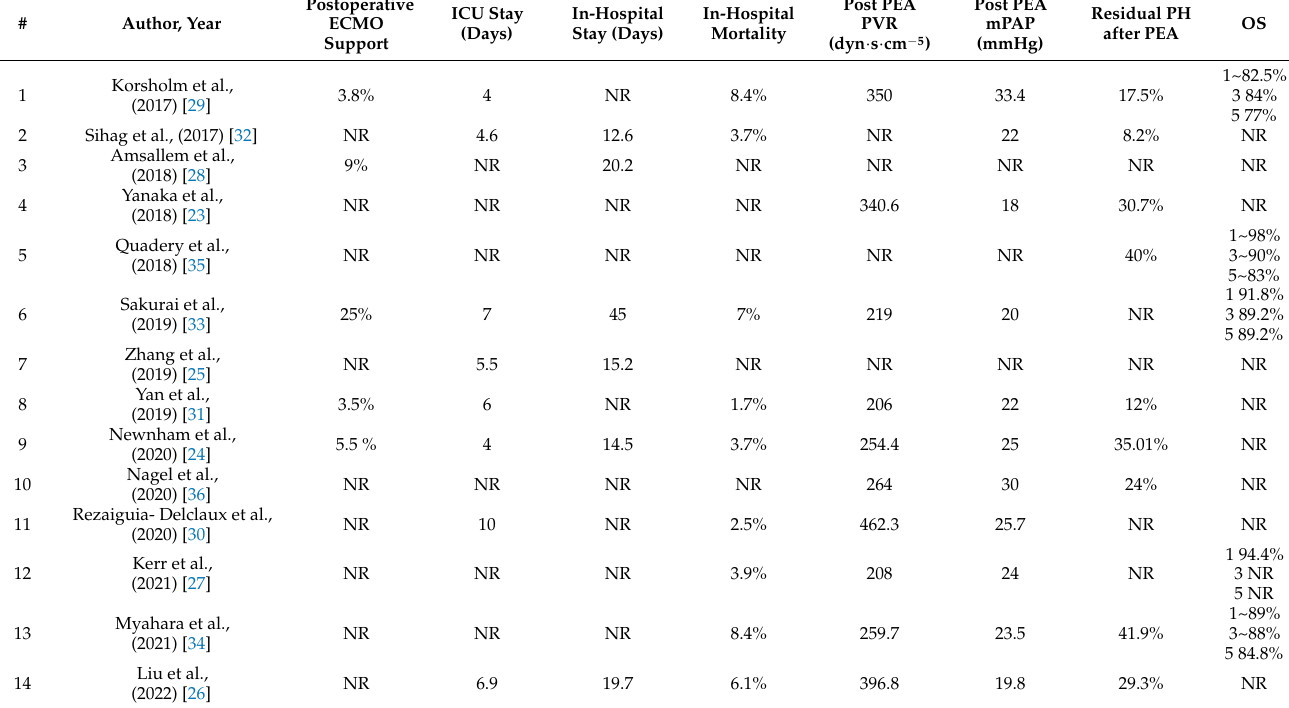
Table 3. Short- and long-term outcomes of patients treated with